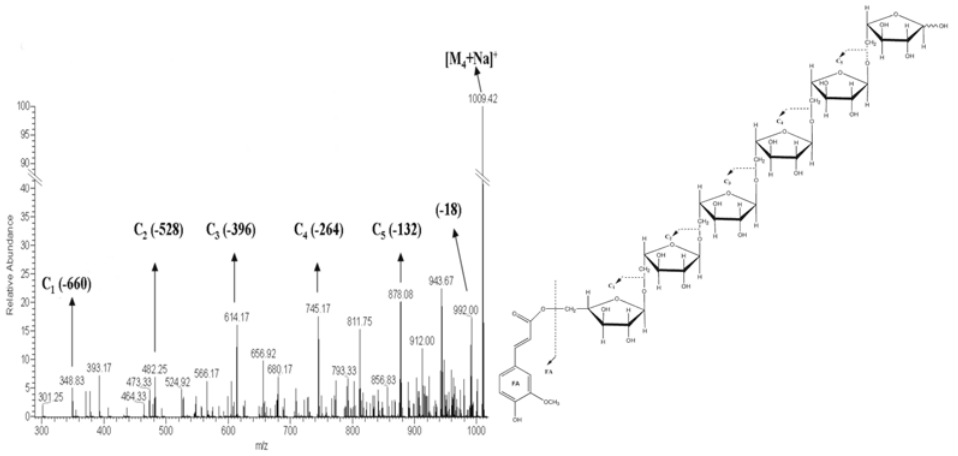
Figure 4. Second order MS of the singly charged parent ion [M feruloylated arabinohexaose ( 4